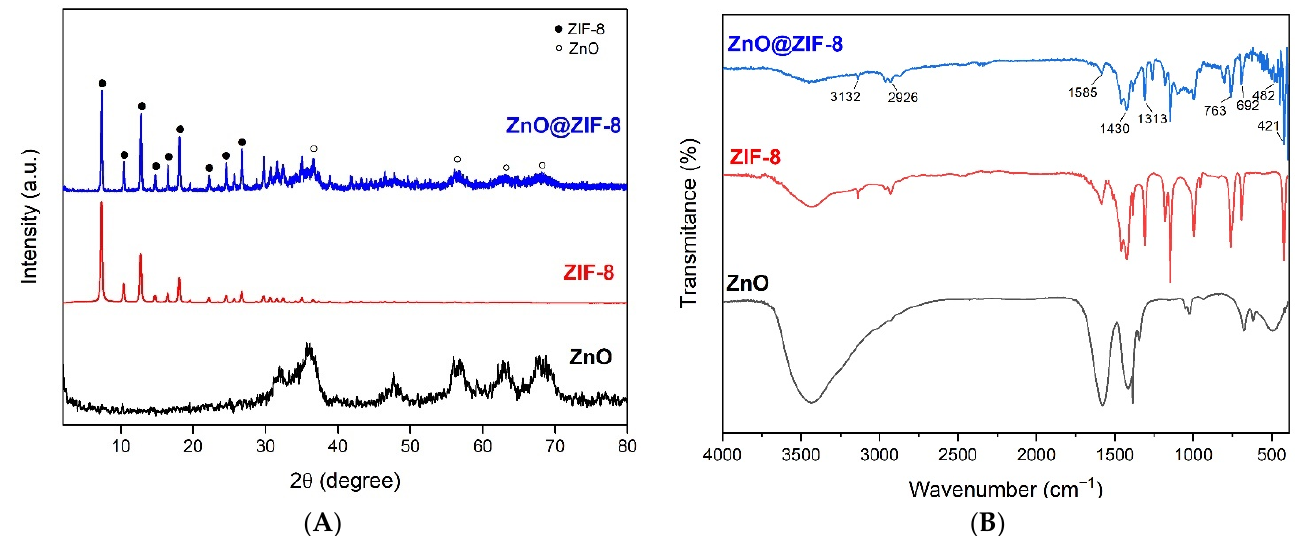
Figure 2. XRD patterns of ZnO NPs, ZIF-8 NPs, and ZnO@ZIF-8 NPs ( A ); FTIR spectra of ZIF-8 and ZnO@ZIF-8 NPs ( B ).